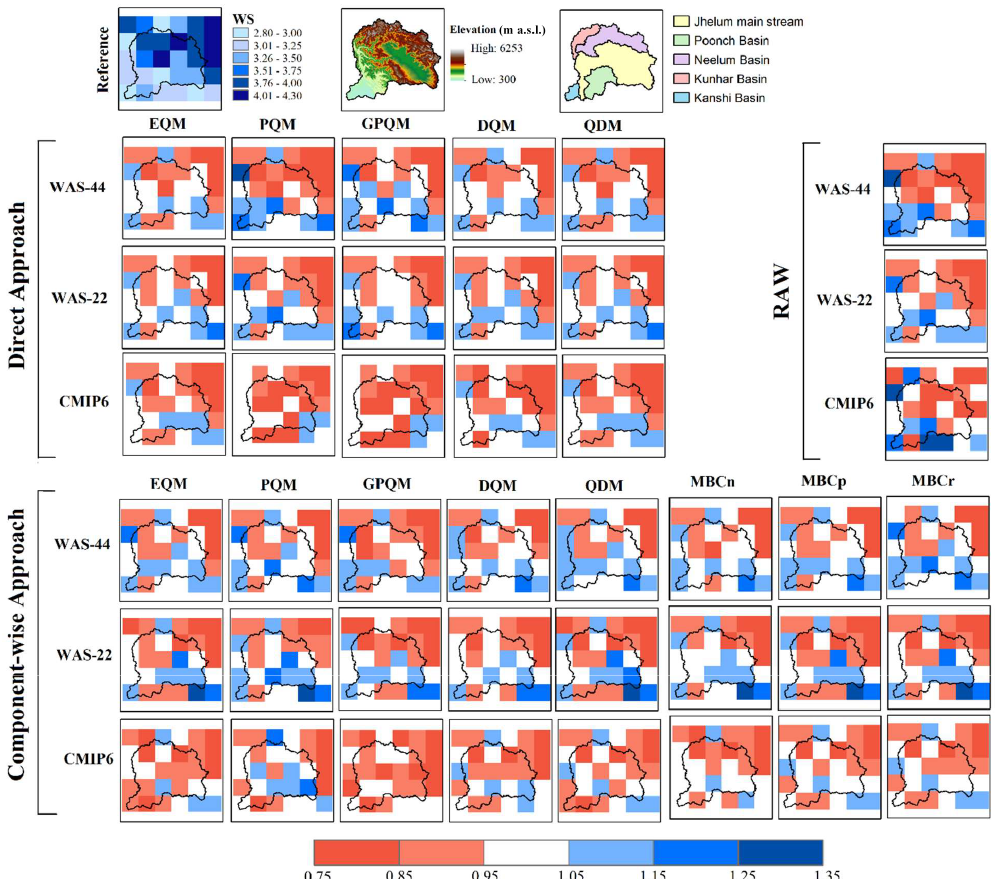
Figure 4. Same as Fig. 3 but for median wet severity (WS), expressed in accumulated SPEI